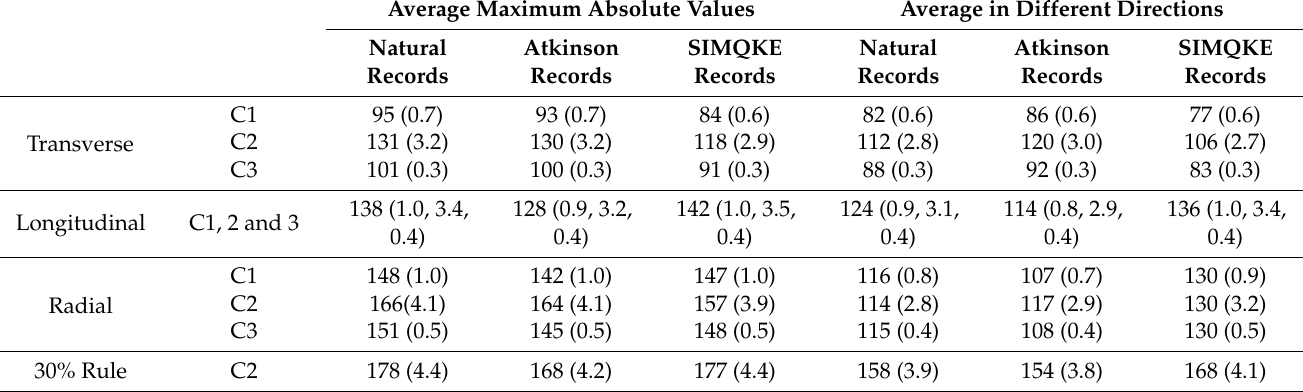
Table 3. Summary of the mean displacements (mm) for columns using 3D analysis for the irregular bridge with mean ductility demands given in